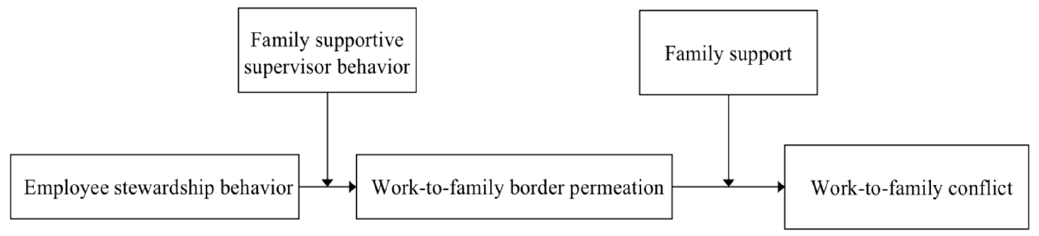
Figure 1. Conceptual research model.